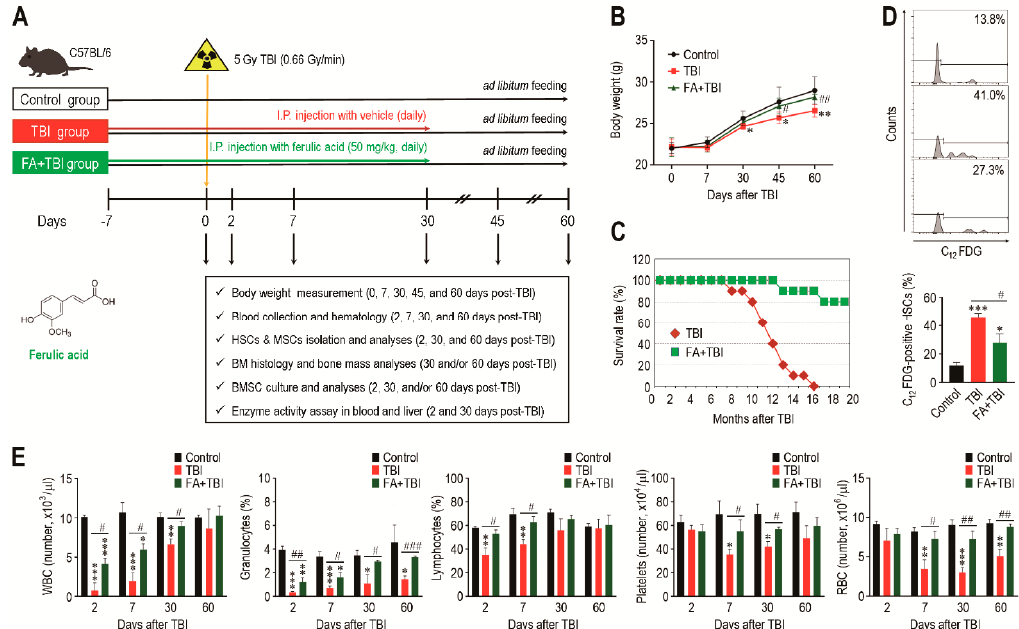
Figure 1. Supplemental ferulic acid diminishes HSC senescence in BM of TBI mice and restores TBI-mediated defects in body growth, survival, and production of circulating blood cells. ( A ) The experimental designs and chemical structure of ferulic acid. ( B ) Body weight (g) of mice groups were measured at the indicated days after TBI ( n = 10). ( C ) Survival rate of mice groups was monitored for the indicated months ( n = 10). ( D ) SA- β -gal activity in HSCs of mice groups was determined by measuring percentage of C 12 FDG-positive HSCs at 2 days post-TBI via flow cytometric analysis ( n = 4). ( E ) Levels of circulating WBC, granulocytes, lymphocytes, platelets, and RBC in mice groups were measured using an automated complete blood cell counter at the indicated days after TBI ( n ≥ 3). All data are presented as the mean ± SD. * p < 0.05, ** p < 0.01, and *** p < 0.001 compared with control group; # p < 0.05, ## p < 0.01, and ### p < 0.001 compared with TBI group.